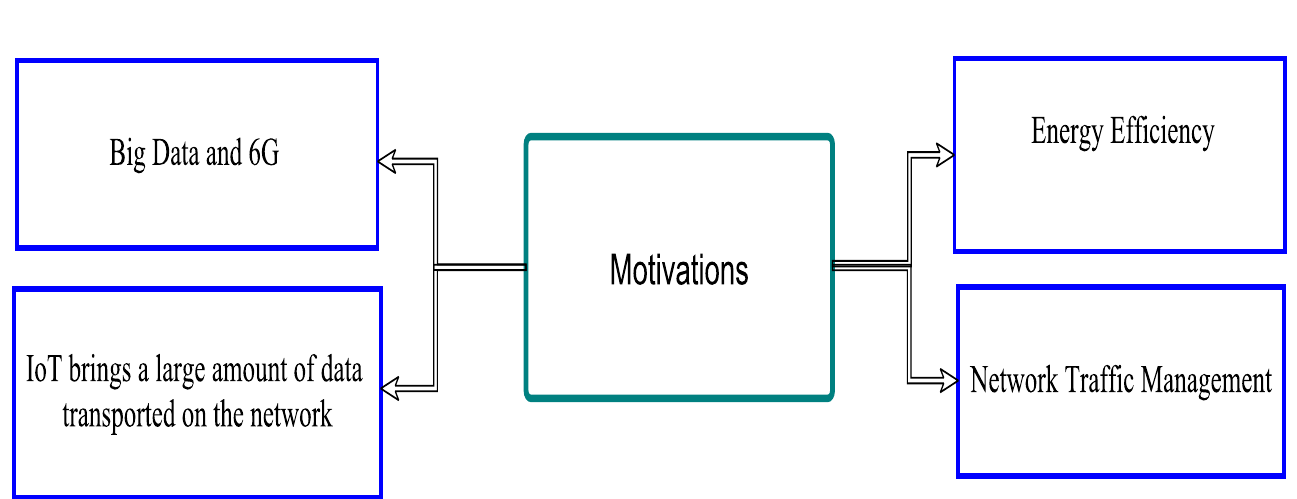
Figure 8. Categories of recommendations according to